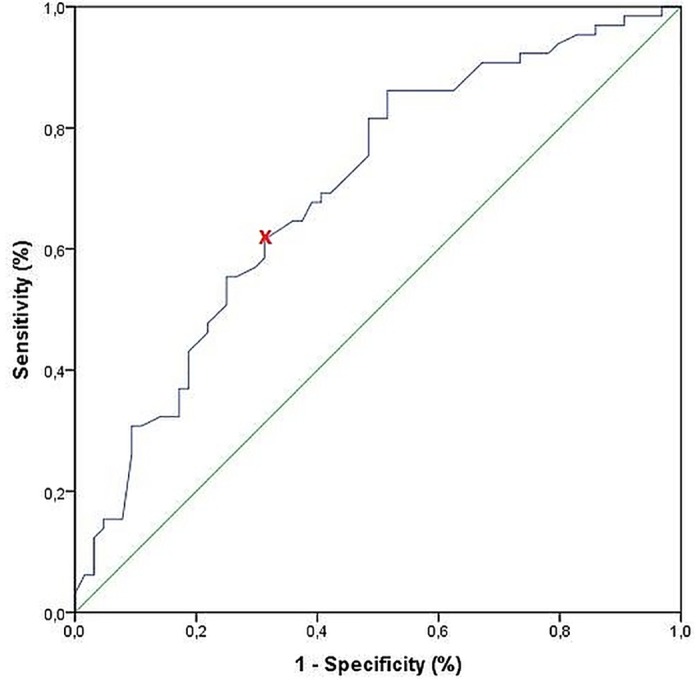
ROC-Curve for cyst diameter as predictor of local complications.Area under the curve (AUC): 0.697. x = cut-off with most equally high sensitivity and specificity: 61,0 mm (sensitivity: 61.5%, specificity: 68.7%).